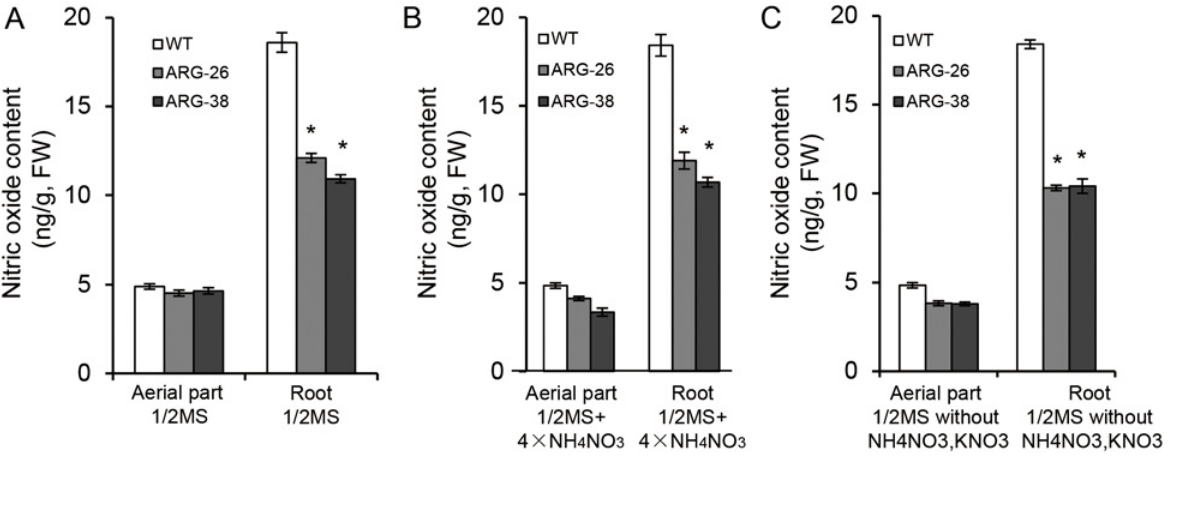
Fig 7. Nitric oxide content analysis in the aerial parts and in the roots of ARG-26 and ARG-38 seedlings grown on 1/2 MS medium, 1/2 MS medium with 4×NH4NO3, and 1/2 MS medium lacking nitrogen. Compared to non-transgenic control plants, the nitric oxide content decreased in the aerial parts and in the roots of ARG-26 and ARG-38 seedlings on all of the various 1/2 MS media compositions. no differences were observed for the aerial parts of the plants. (A) the nitric oxide content in seedlings of transgenic cotton grown on 1/2 MS medium. (B) the nitric oxide content in transgenic cotton seedlings grown on 1/2 MS medium with 4× NH 4 NO 3 . (C) the nitric oxide content in transgenic cotton seedlings grown on 1/2 MS medium lacking NH 4 NO3 and KNO3. ‘ FW ’ refers to fresh leaf weight. ‘ WT ’ refers to non-transgenic control plants of wild type cotton. * : P < 0.05.